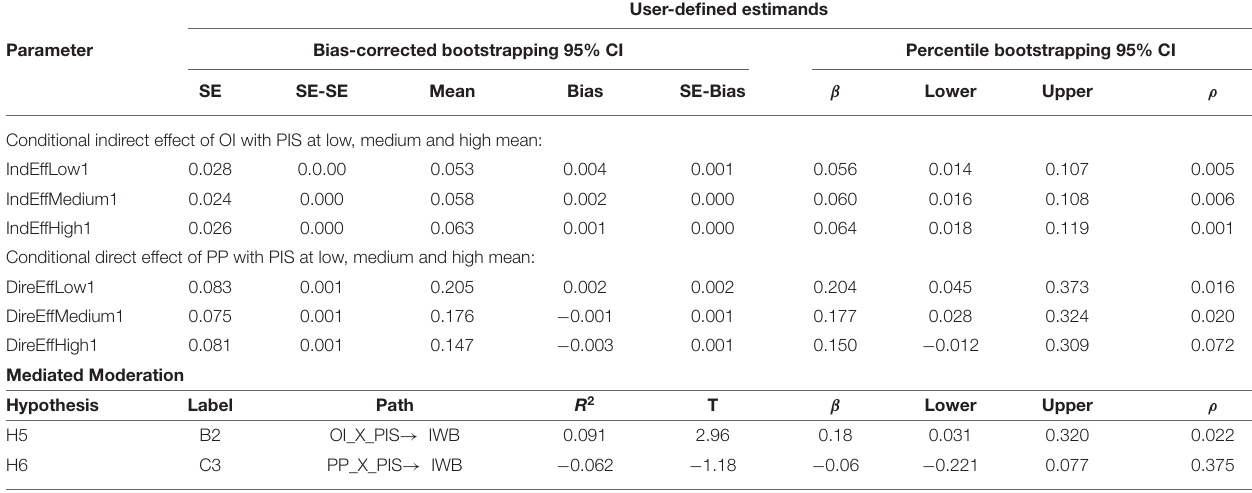
TABLE 9 | Conditional direct and indirect